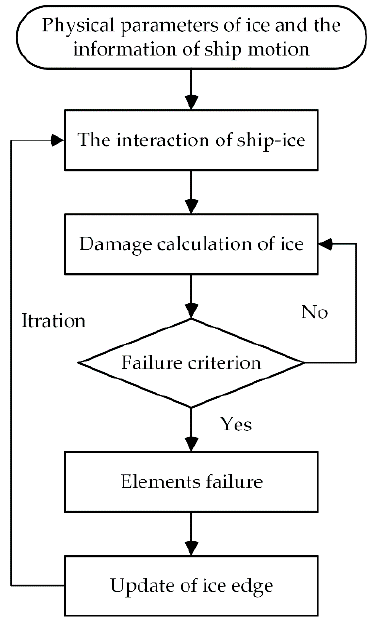
Figure 2. The solution process of ship–ice interaction.